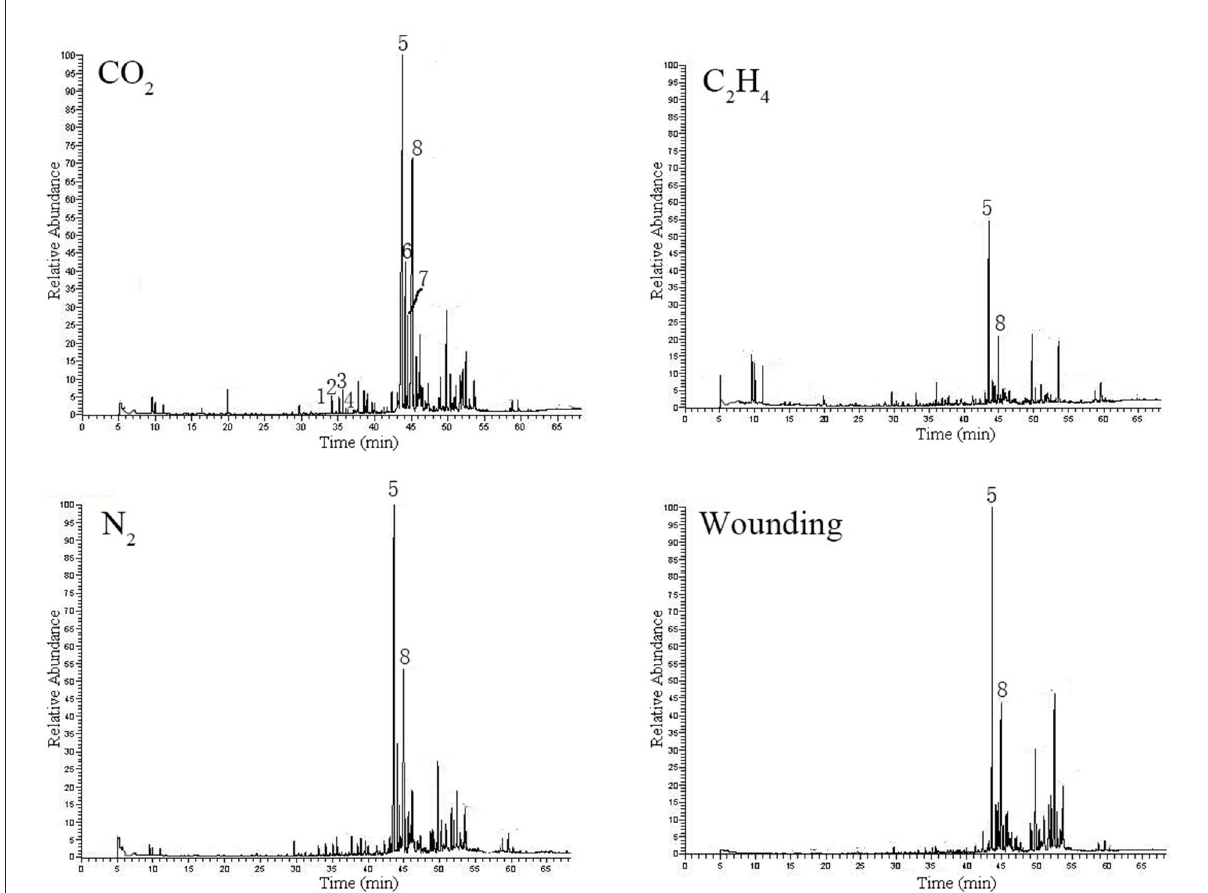
FIGURE6 Total ion chromatogram of essential oil extracted from sandal induced by gas elicitors. 1: α -santalene 2: α -bergamotene 3: epi- β -santalene 4: β -santalene 5: α -santalol 6: α - trans -bergamotenol 7: epi- β -santalol 8: β